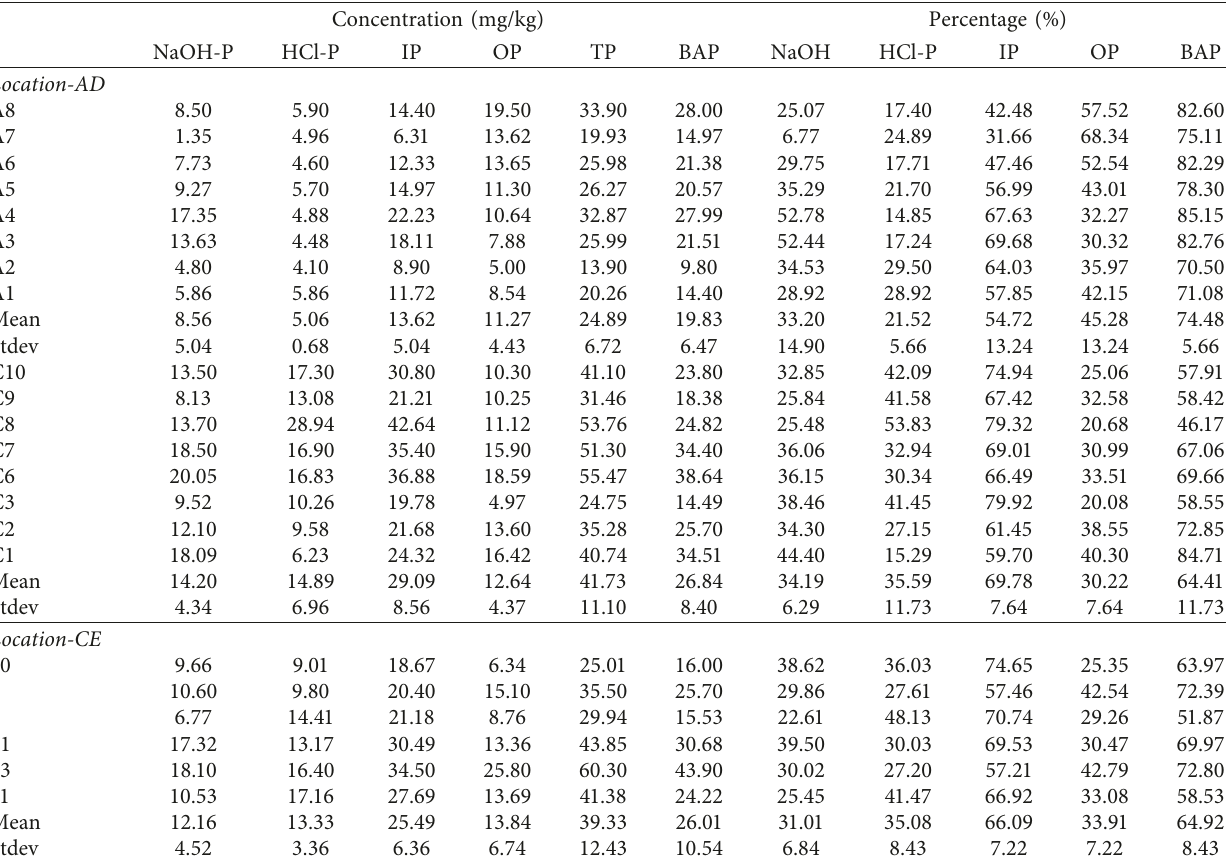
Table 1: Sedimentary P species as elucidated from the SMT